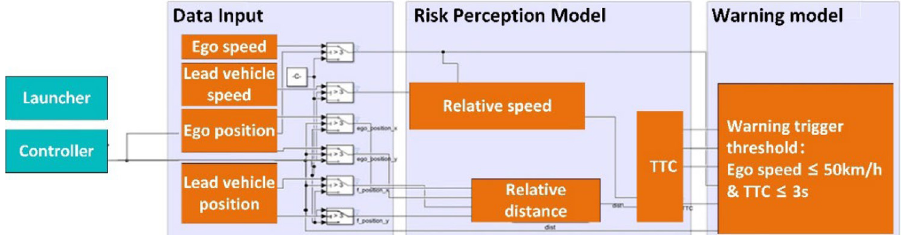
Figure 4 Simulink framework for warning